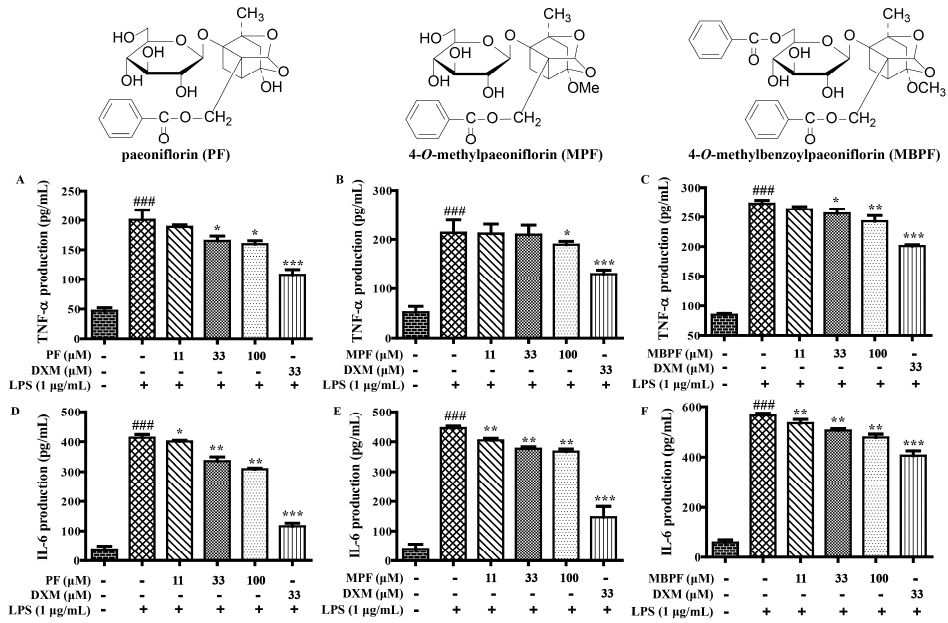
Figure 2. The effects of PF, MPF and MBPF on the production of tumor necrosis factor alpha (TNF- α ) and interleukin-6 (IL-6) in LPS-induced RAW 264.7 cells. The cells were treated with different concentrations of PF, MPF and MBPF (0, 11, 33, and 100 μ M) for 2 h, and were then stimulated with or without LPS (1 μ g/mL) for 12 h. The culture medium was collected to detect the production of TNF- α ( A – C ) and IL-6 ( D – F ) were measured using Elisa kits. ( ### p < 0.001 vs. control group; * p < 0.05, ** p < 0.01, *** p < 0.001, vs. LPS group).